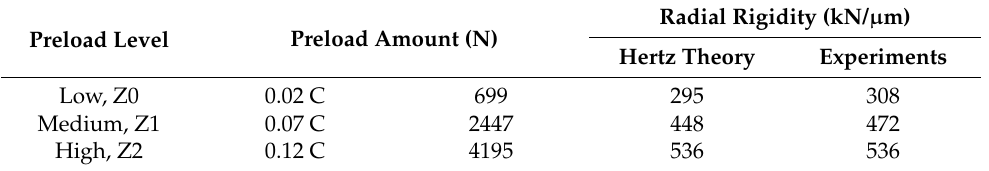
Table 2. Preload and rigidity of the linear guides.